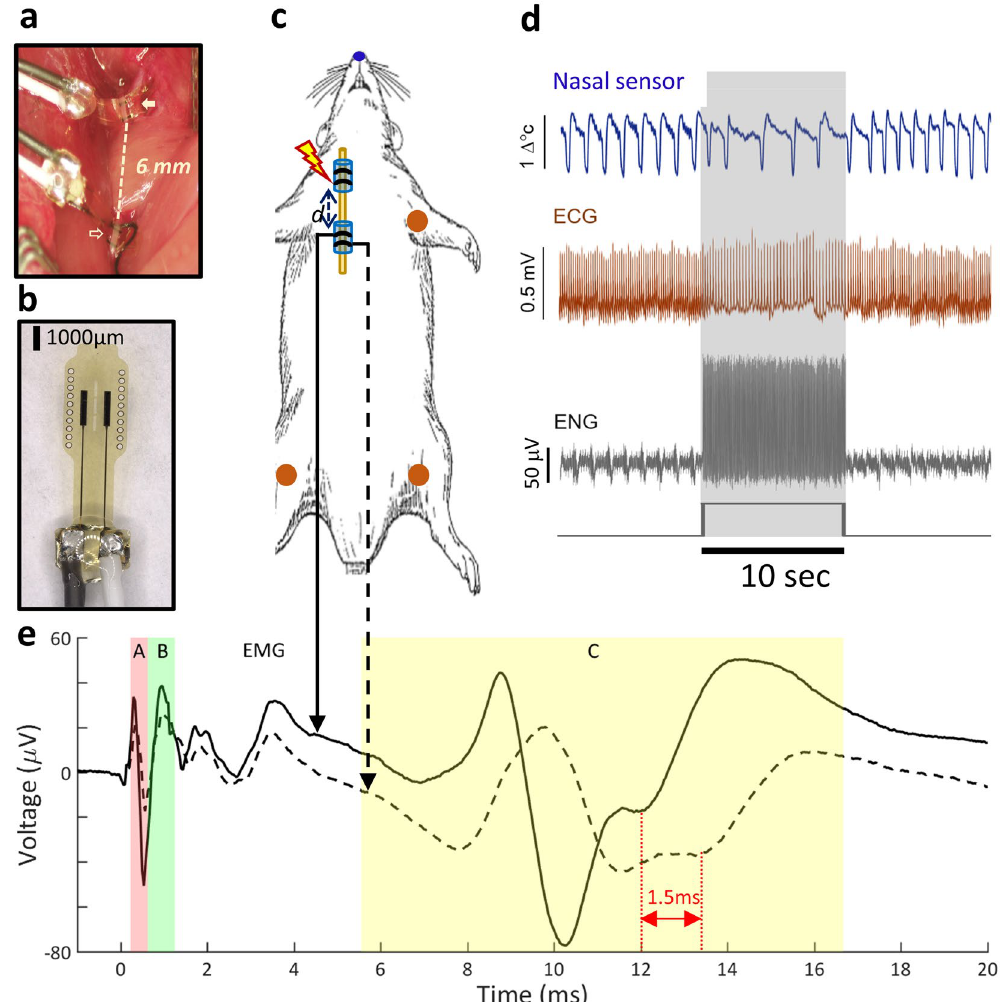
Figure 6. Experimental setup, electrodes, physiological sensors and signals. ( a ) Two bipolar cuff electrodes shown placed below corresponding exposed parts of the cervical vagus nerve in a rat, at a distance of 6 mm from each other. The rostral electrode (filled arrow) is used for stimulation, the caudal (open arrow) for recording. ( b ) Close-up image of a bipolar, Flex electrode. ( c ) Schematic of the animal with the 2 vagus nerve electrodes and the sensors for physiological measurements: nasal temperature sensor for resolving air flow (blue), electrocardiogram (ECG) sensors (2 differentials and 1 ground) for registering ECG (red). ( d ) Snippet of signals acquired during delivery of a 10 s-long (300 pulse count) VNS train (rectangular black trace at bottom panel): temperature signal from nasal sensor (top panel, blue trace), voltage signal from ECG sensor (second panel, red trace), electroneurogram (ENG) signal from recording nerve electrode (third panel, grey trace). In the raw ENG signal, periodic modulations associated with breathing and stimulation artifacts associated with VNS were also observed. ( e ) Stimulus-evoked compound nerve action potential (sCNAP) compiled by averaging single ENG sweeps around the onset of each of the 300 stimuli in the VNS train. The solid and the dotted trace represent the 2 sCNAPs recorded on the 2 contacts of a bipolar recording cuff; notice the time-shift in the 2 traces for slow- conducting C-fibers, corresponding to different arrival times of CNAPs at the 2 recording contacts, and the lack of time-shift for extra-neural EMG, which is recorded simultaneously on both contacts. The colored shaded areas represent the windows of latencies (minimum and maximum latency) for each of the 3 fiber type and EMG activity: red for A fibers (0.3–0.95 ms), green for B fibers (0.7–1.2 ms), yellow for C fibers (5.5–16.6 ms) and white for EMG (2–10 ms). The latency windows were calculated based on the known conduction velocities of fibers types and distance between stimulating and recording electrodes. The magnitude of activation for each fiber type was calculated as the amplitude of the CNAP component within each of the 4 latency